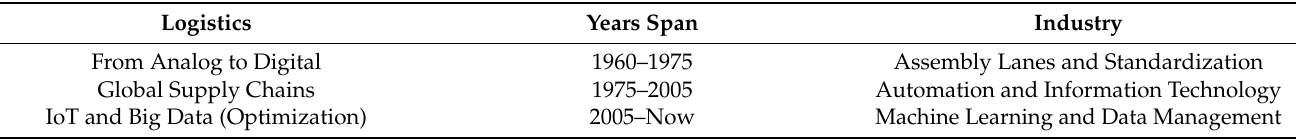
Table 6. The impact of industrial revolutions on the evolution of logistics.